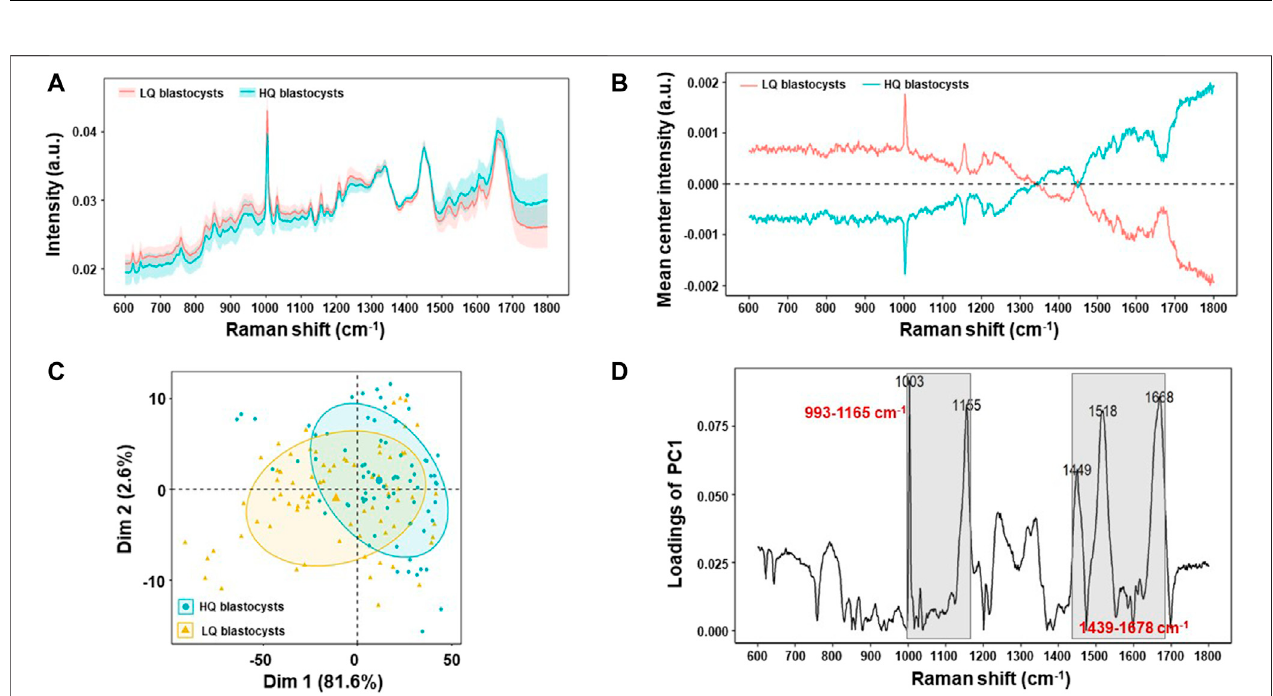
FIGURE 4 | Raman pro fi ling of follicular fl uid between high-quality blastocysts group (HQ group) and low-quality blastocysts group (LQ group) of PCOS. (A) Averaged Raman spectra of follicular fl uid of HQ group ( n (cid:1) 75) and LQ group ( n (cid:1) 75) patients. Shaded areas represent the standard deviations. (B) Mean-centered Raman spectra differences between HQ group and LQ groups by subtracting means from all samples. (C) Principal component analysis (PCA) of all Raman Spectra to show the clustering of HQ group and LQ groups. (D) Raman wavenumber loading plots of contributions along dimension 1 of the PCA, where grey boxes indicate the two Raman zones responsible for the most signi fi cant variances between the two groups by comparing the quanti fi ed spectral intensity values.